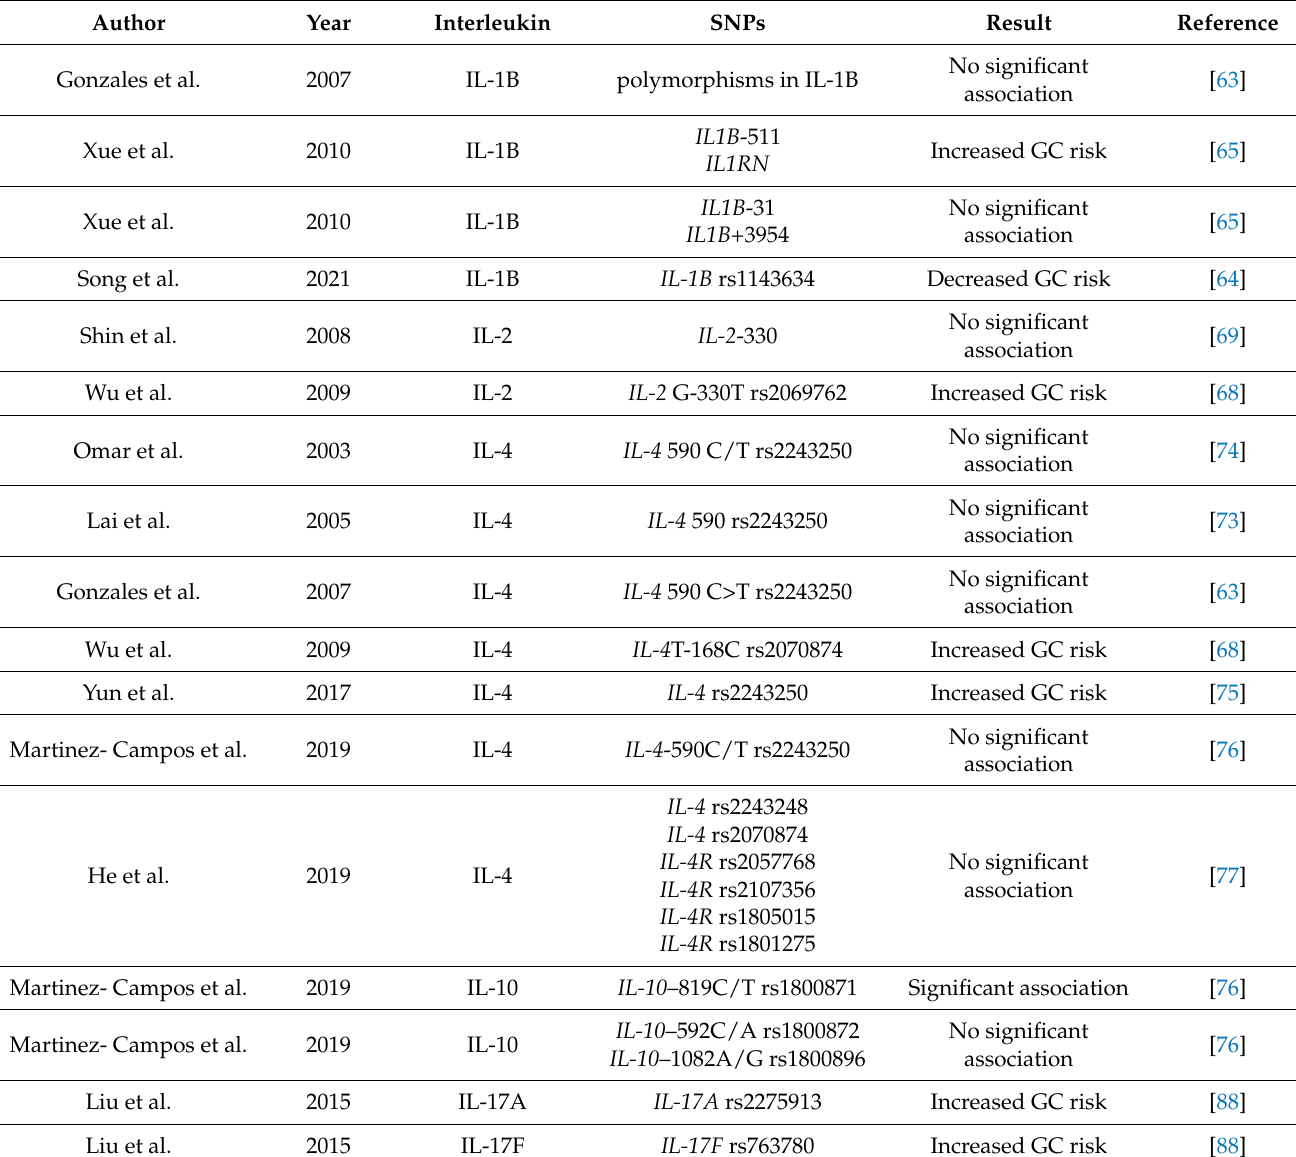
Table 2. The role of polymorphism in interleukins in the development of GC.